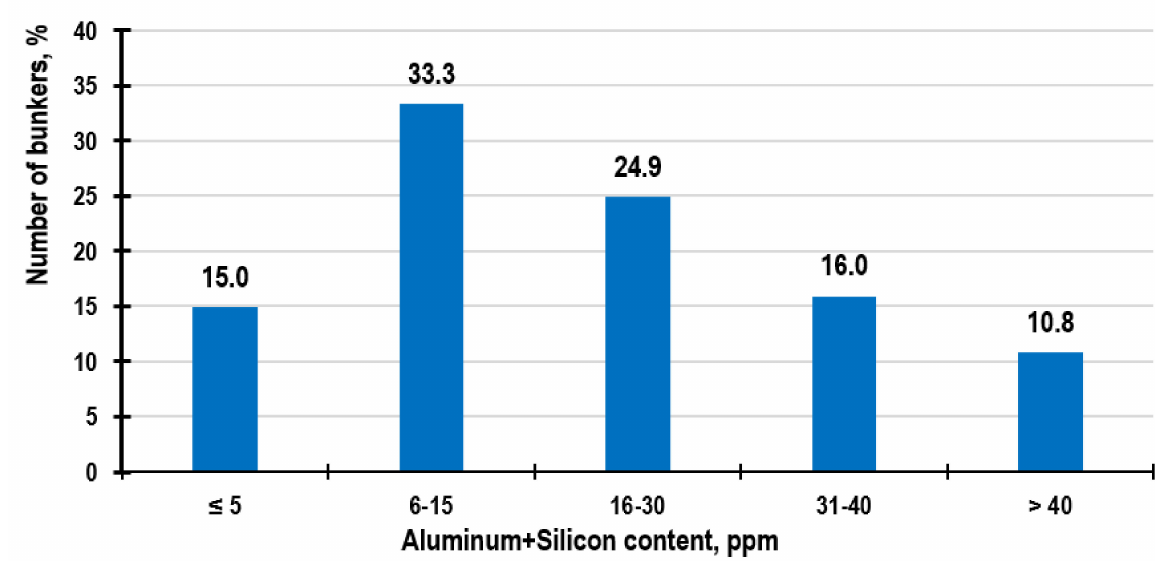
Figure 3. The total content of aluminum plus silicon in VLSFO